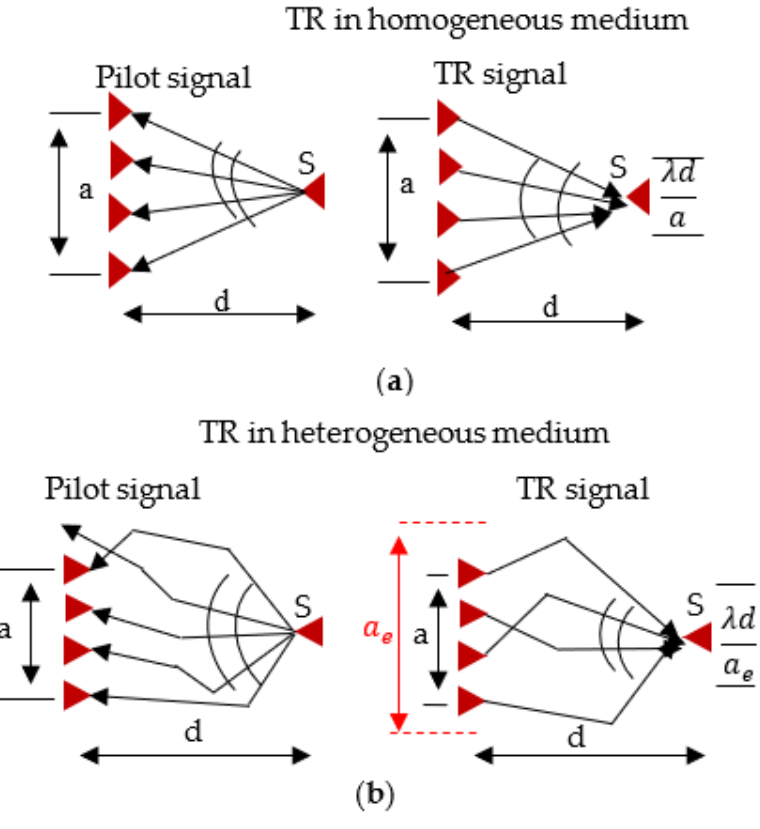
Figure 10. Time-reversal approach. ( a ) TR in a homogeneous medium, a point source S emits a pilot signal which is received at the array of aperture a at a distance d from the source, the signal is time reversed and sent back into the medium. The cross-range resolution is proportional to ( λ d/a). Here λ is the wavelength at the corresponding frequency. ( b ) TR in an inhomogeneous medium with strong multipath reflection. The retrodirective Tx array appears to have an effective aperture a e > a , and the focusing spot is tighter than that in homogeneous medium.